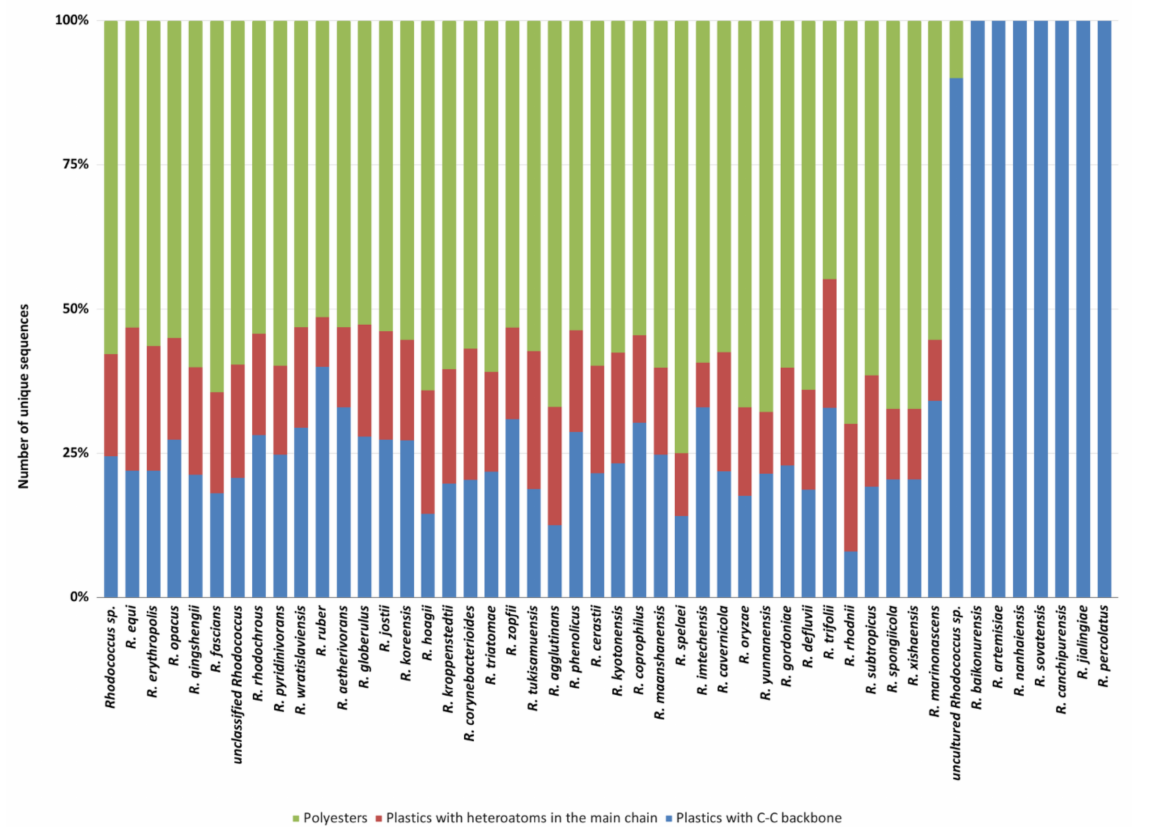
Figure 5. Normalized number of unique HIT sequences identified in Rhodococcus species genomes for each polymer category: polyesters, heteroatomic backbone plastics, and C − C backbone